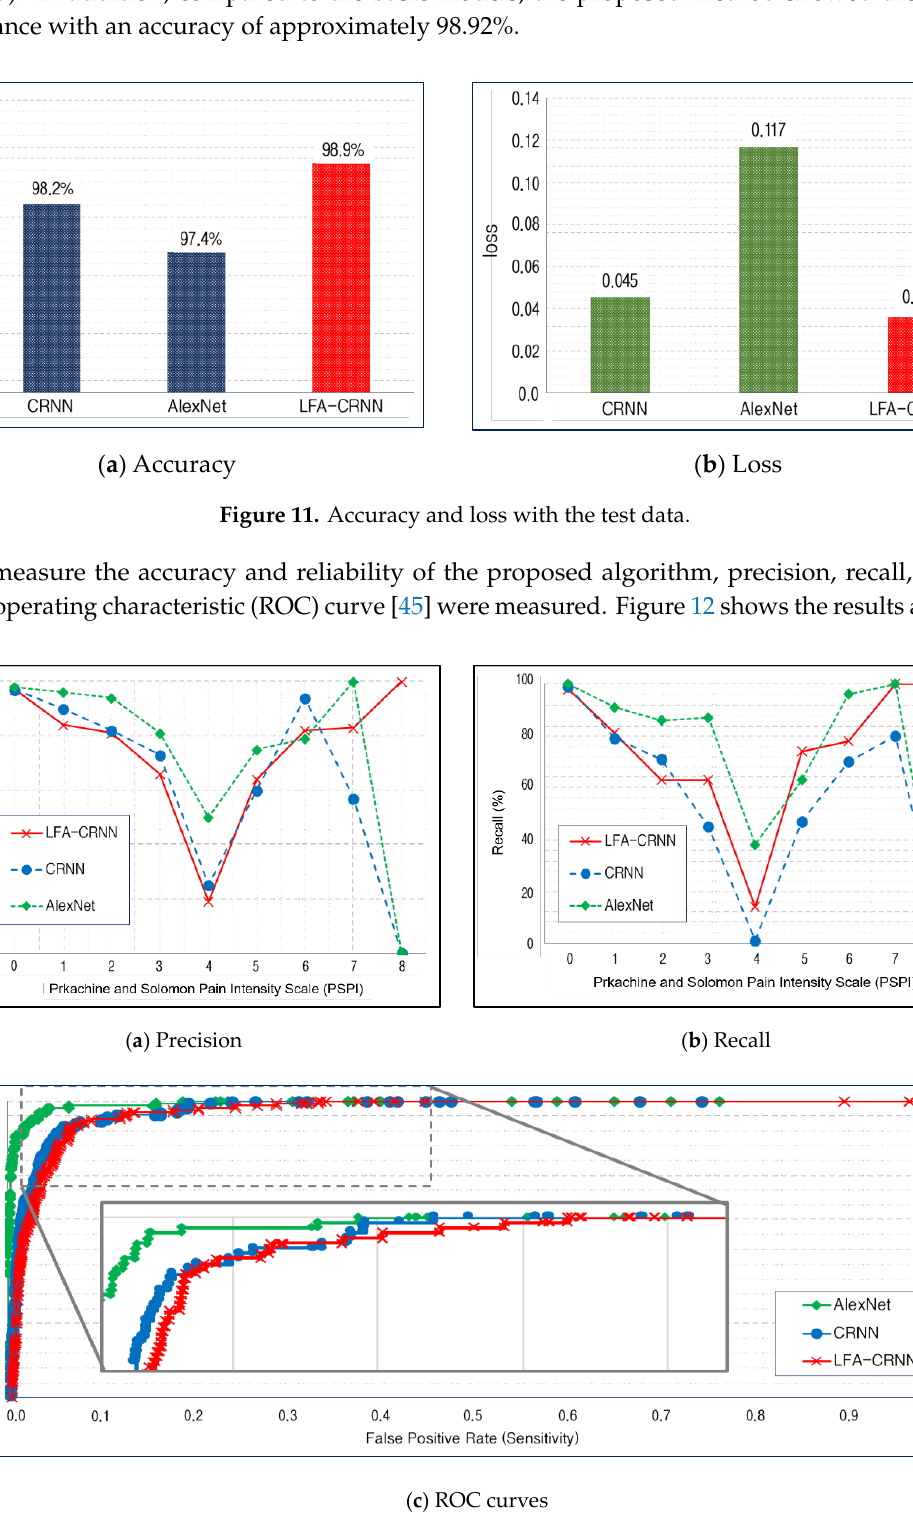
Figure 12. Results of precision and recall, plus the receiver operating characteristic (ROC) curve evaluation for each algorithm.